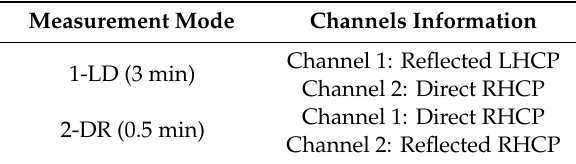
Table 1. Data Acquisition Schedule.